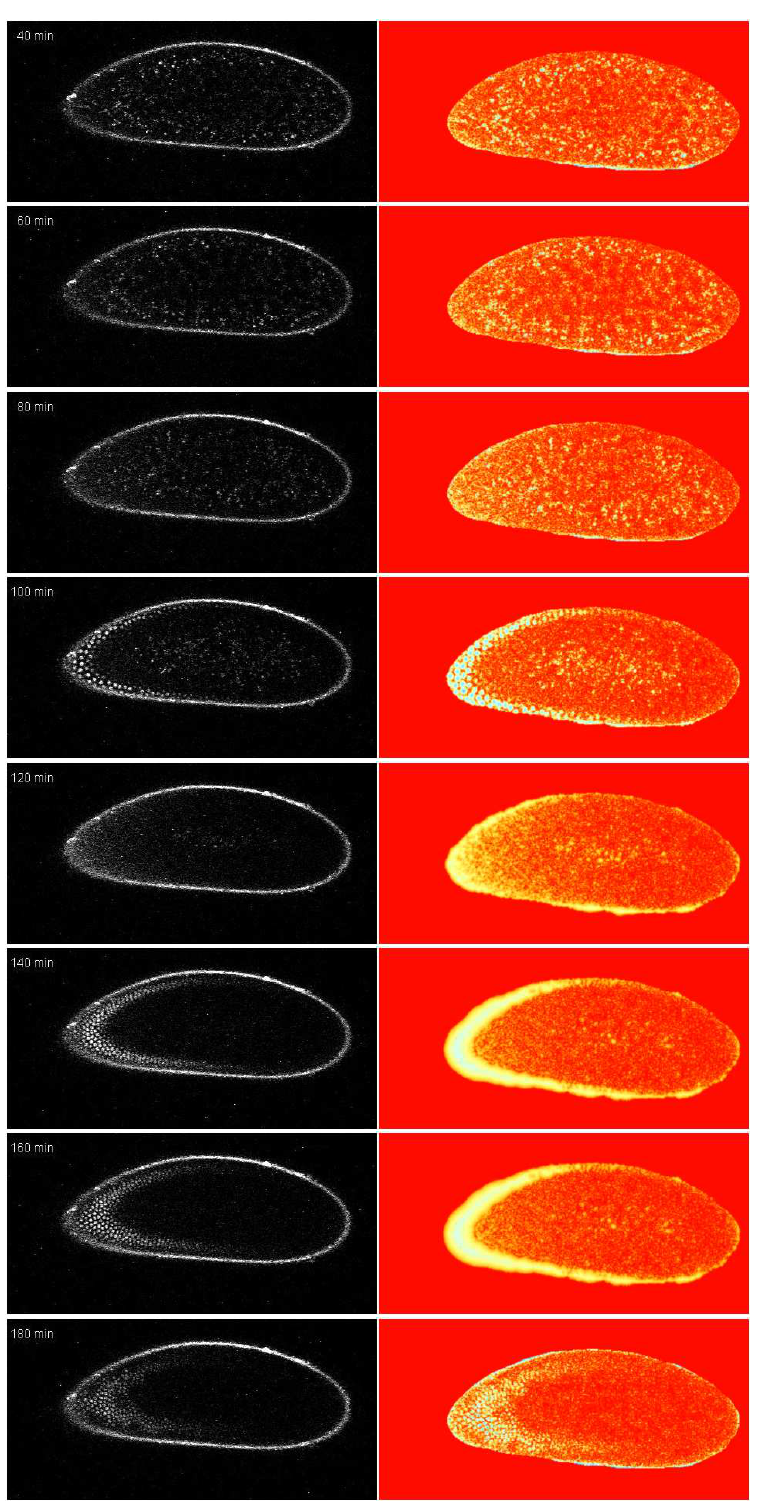
Figure 7: Experimental video frames (black figures on the left) and Redi simulated video frames (red heat-color maps on the right). The simulated images are an average of 100 stochastic simula-